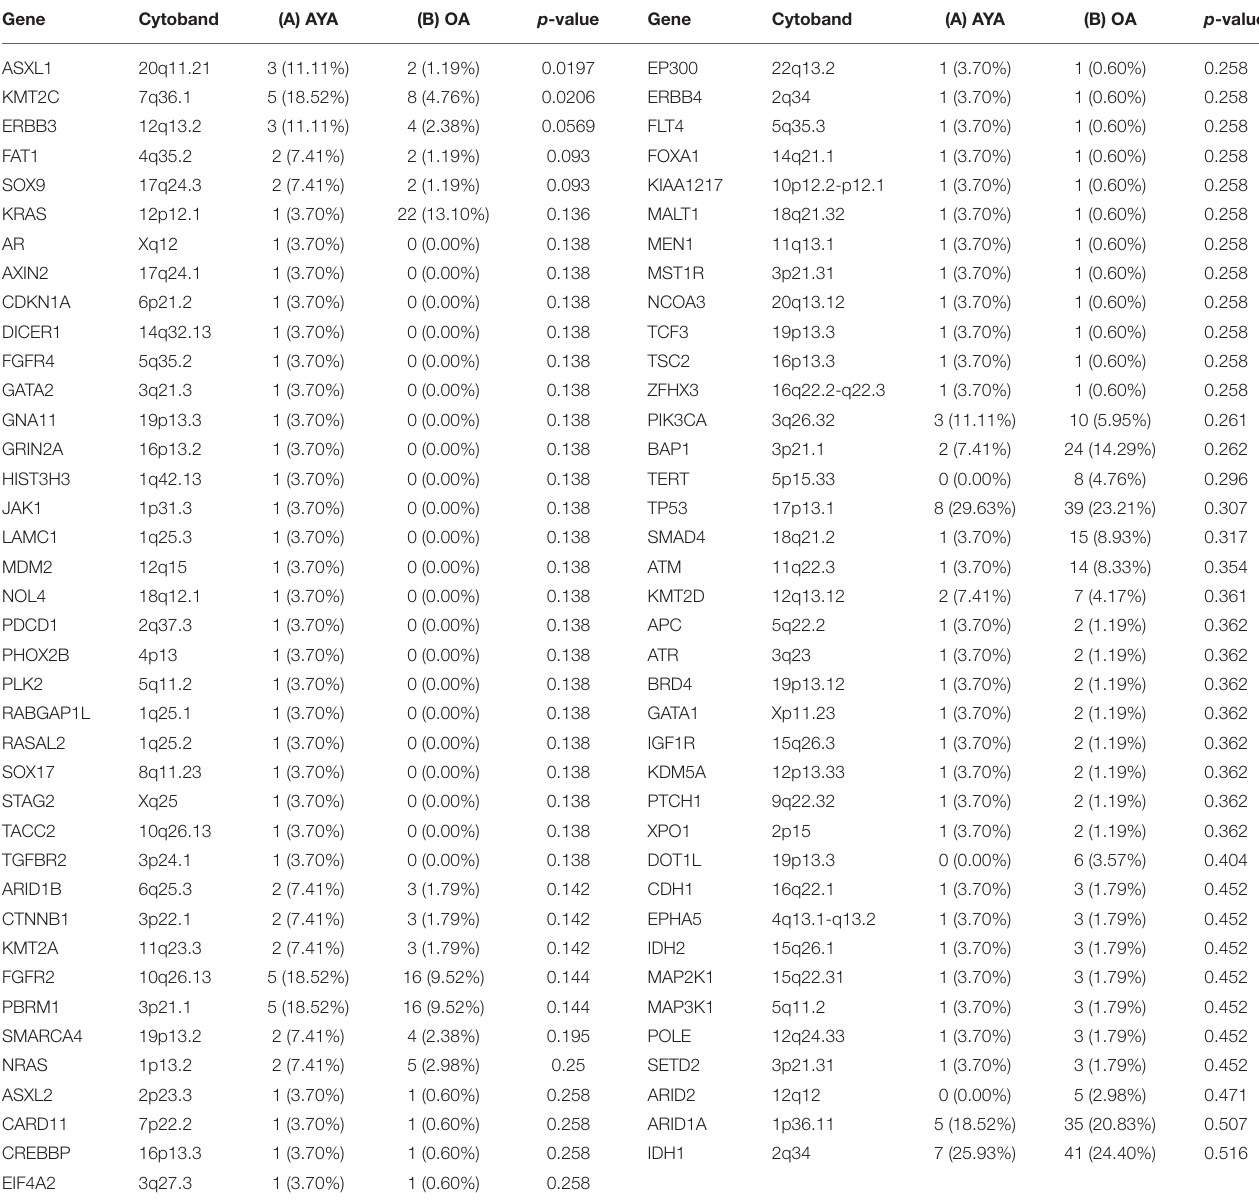
TABLE 2 | Comparison of genes with different mutation frequency in both groups. Gene